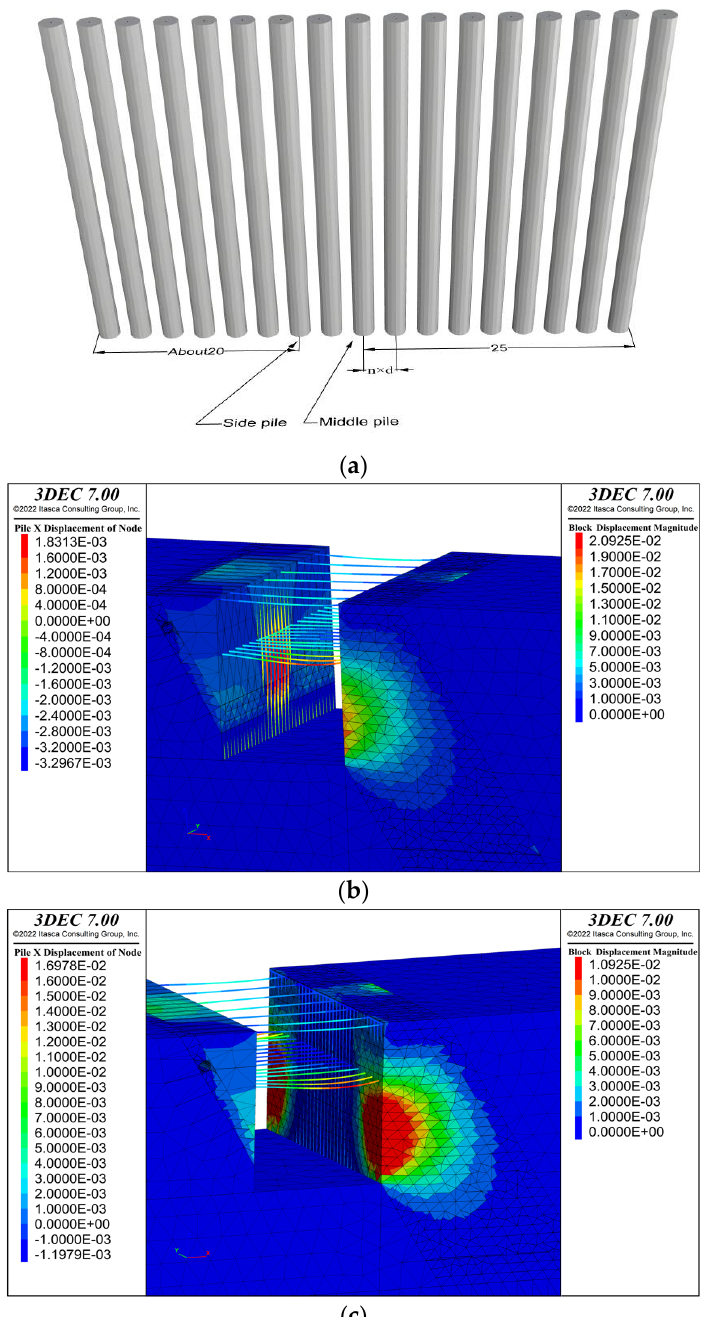
Figure 10. Numerical analysis of pile-bracing support with 1.5 times pile spacing. ( a ) schematic diagram for setting analysis points of retaining piles (unit: m, scale: 1:100); ( b ) failure and deformation cloud of bedding rock side; ( c ) failure and deformation cloud of toppling rock side.